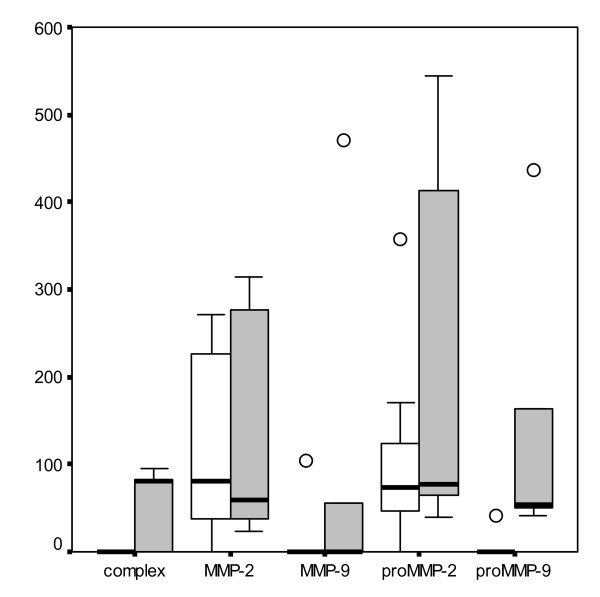
Mean ± s.d. urine gelatinolytic activity in control group □ and in colic group ■. MMP-9 complex, proMMP-9, MMP-9, proMMP-2 and MMP-2 activities are expressed as an area under the brightness-to-width curve of each gelatinolytic band in zymogram.